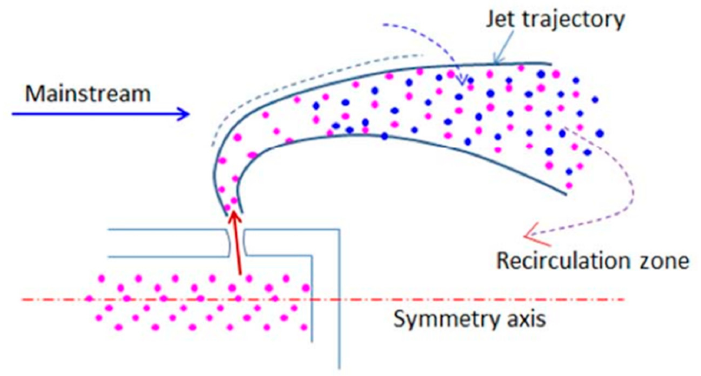
Figure 8. Schematic of a circular transverse jet in cross flow [45].